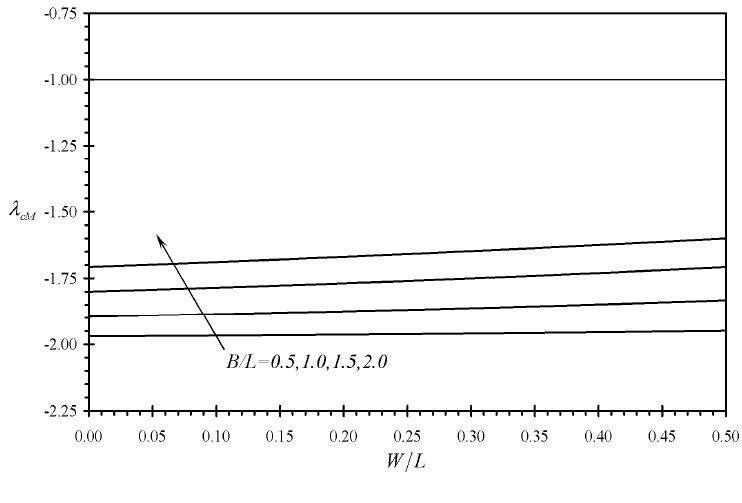
Figure 7. Effects of the relative dimensions of the microcantilevers assemblies (b) and (c) on the second performance indicators λ cM